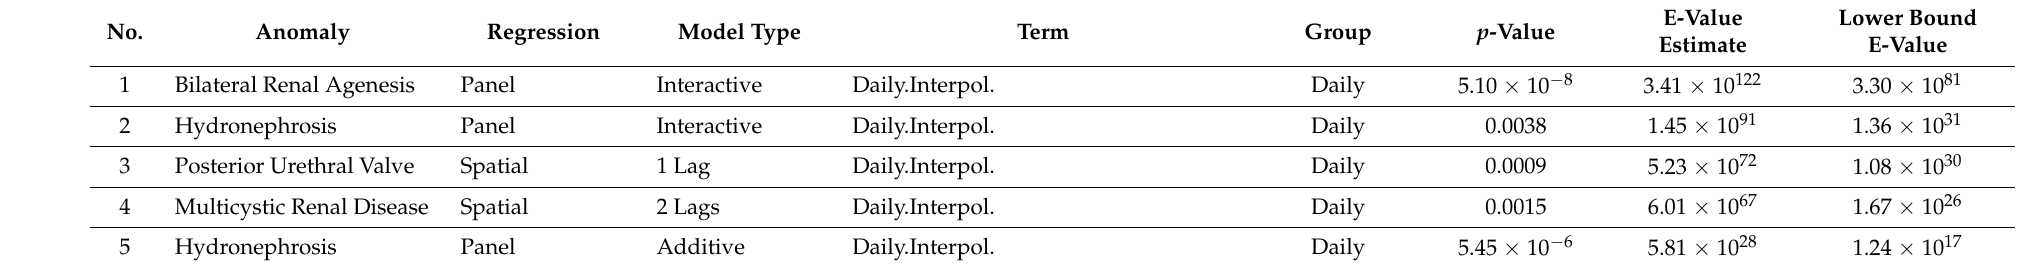
Table 13. E-Values by